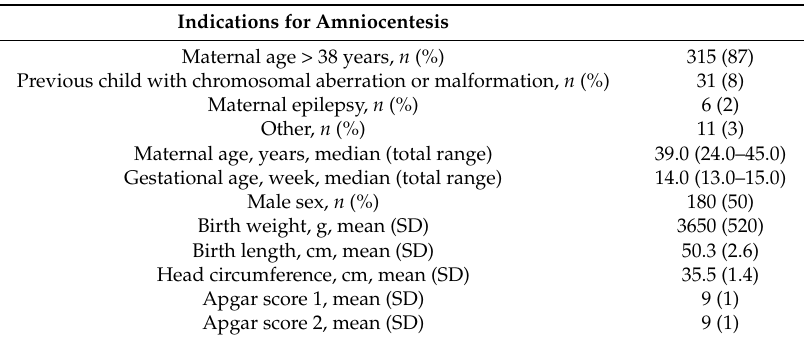
Table 1. Characteristics of the population ( n = 363).